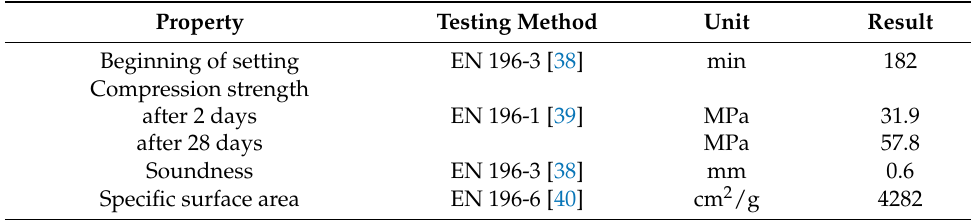
Table 6. Properties of CEM I 42.5R Portland cement.